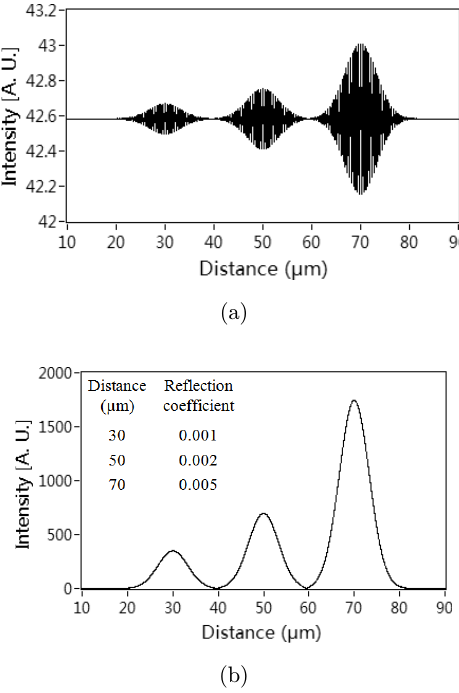
Fig. 10. The simulation result of sample 2 by the TD-OCT A- scan program. (a) The interference fringe. (b) The post-pro- cessed OCT image re°ects the depth-resolved structural infor- mation of the simulated phantom.